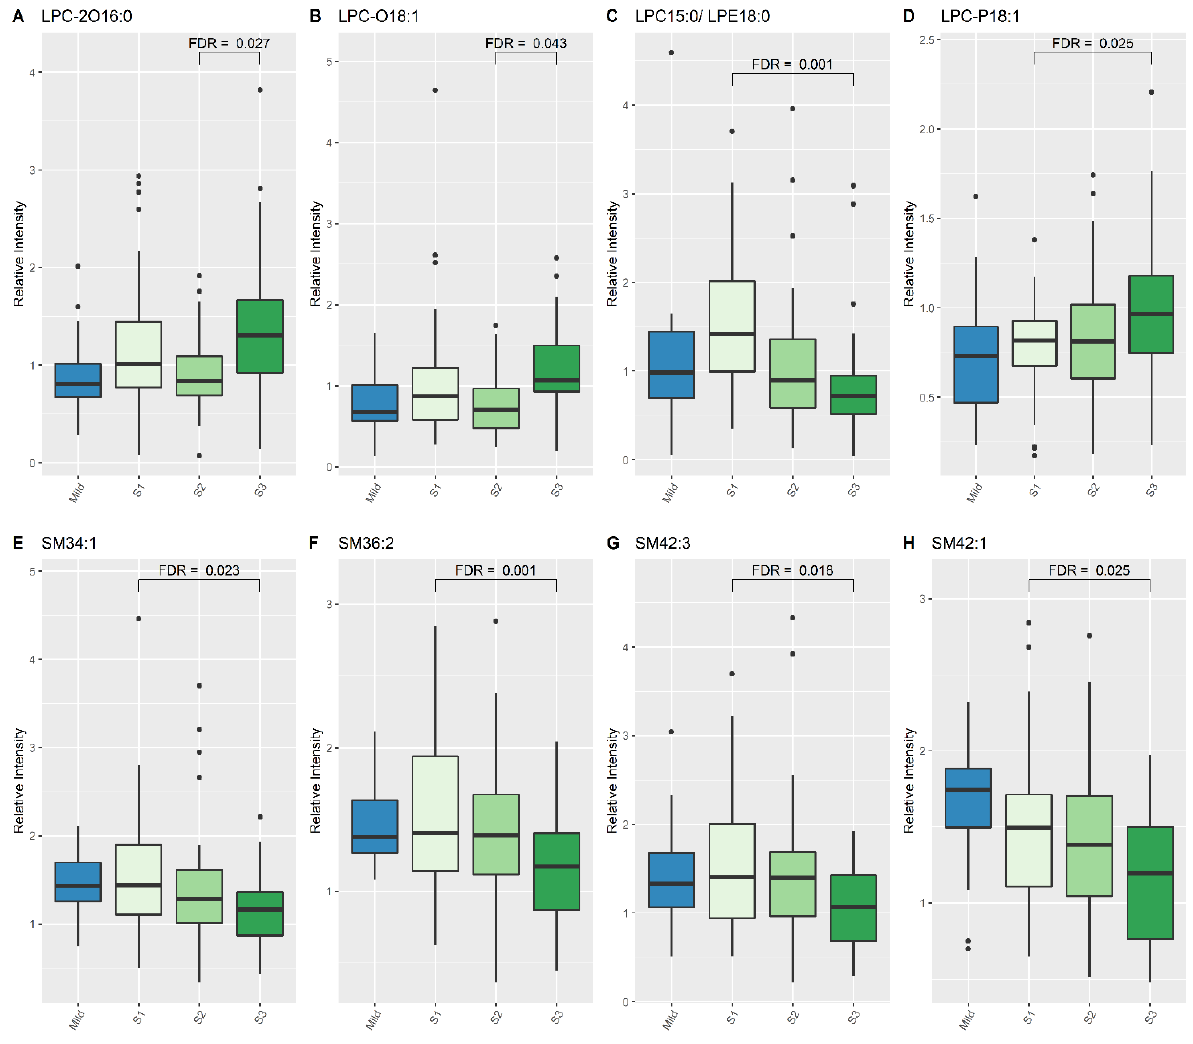
Figure 2. Lipid species from LPC and SM classes which show differences between Mild HIE cases and Moderate–severe HIE cases at different time points (S1, S2 and S3). ( A ), LPC 2016:0; ( B ), LPC 018:1; ( C ), LPC 15:0/LPE18:0; ( D ), LPC P18:1; ( E ), SM34:1; ( F ), SM36:2; ( G ), SM42:3; ( H ), SM42:1.